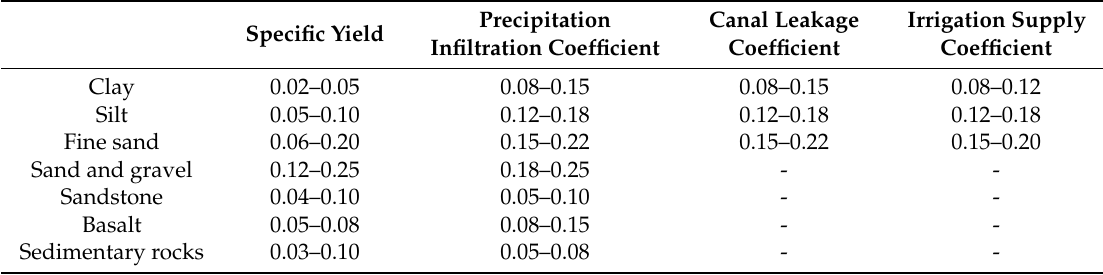
Table 2. The range of the main parameters.